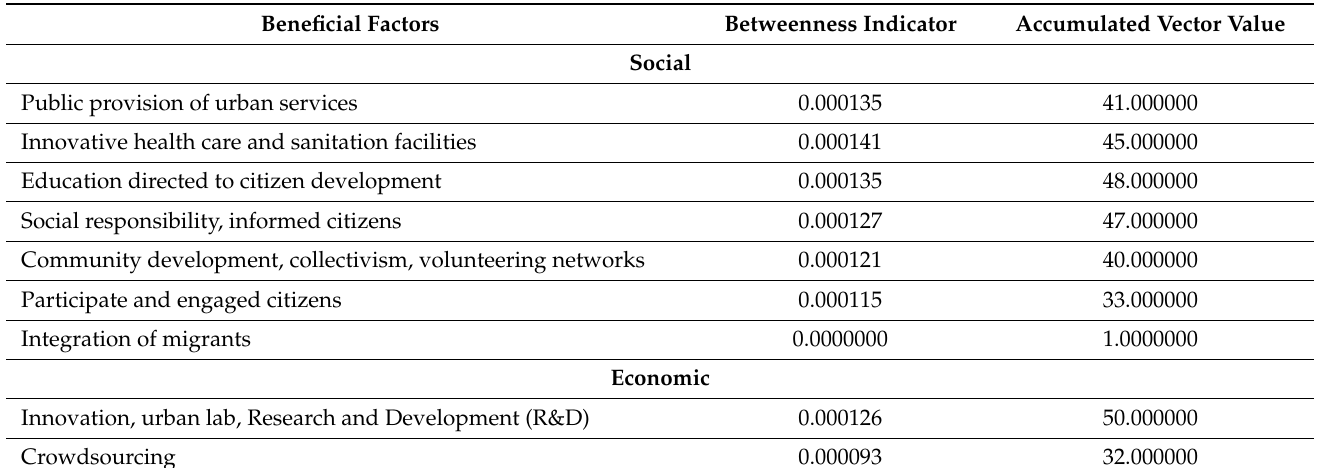
Table A8. Cumulative list of scoring for the beneficial factors of the development of smart cities in Poland based on expert opinion. Source: Own